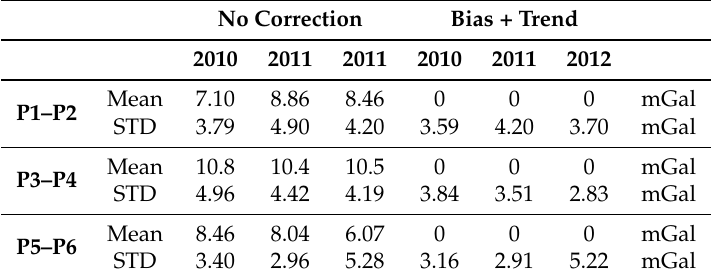
Table 6. Mean and standard deviation of the difference in gravity estimates along the three profiles. The gravity estimates were smoothed by increasing the correlation parameter to 1/ β = 30 km.